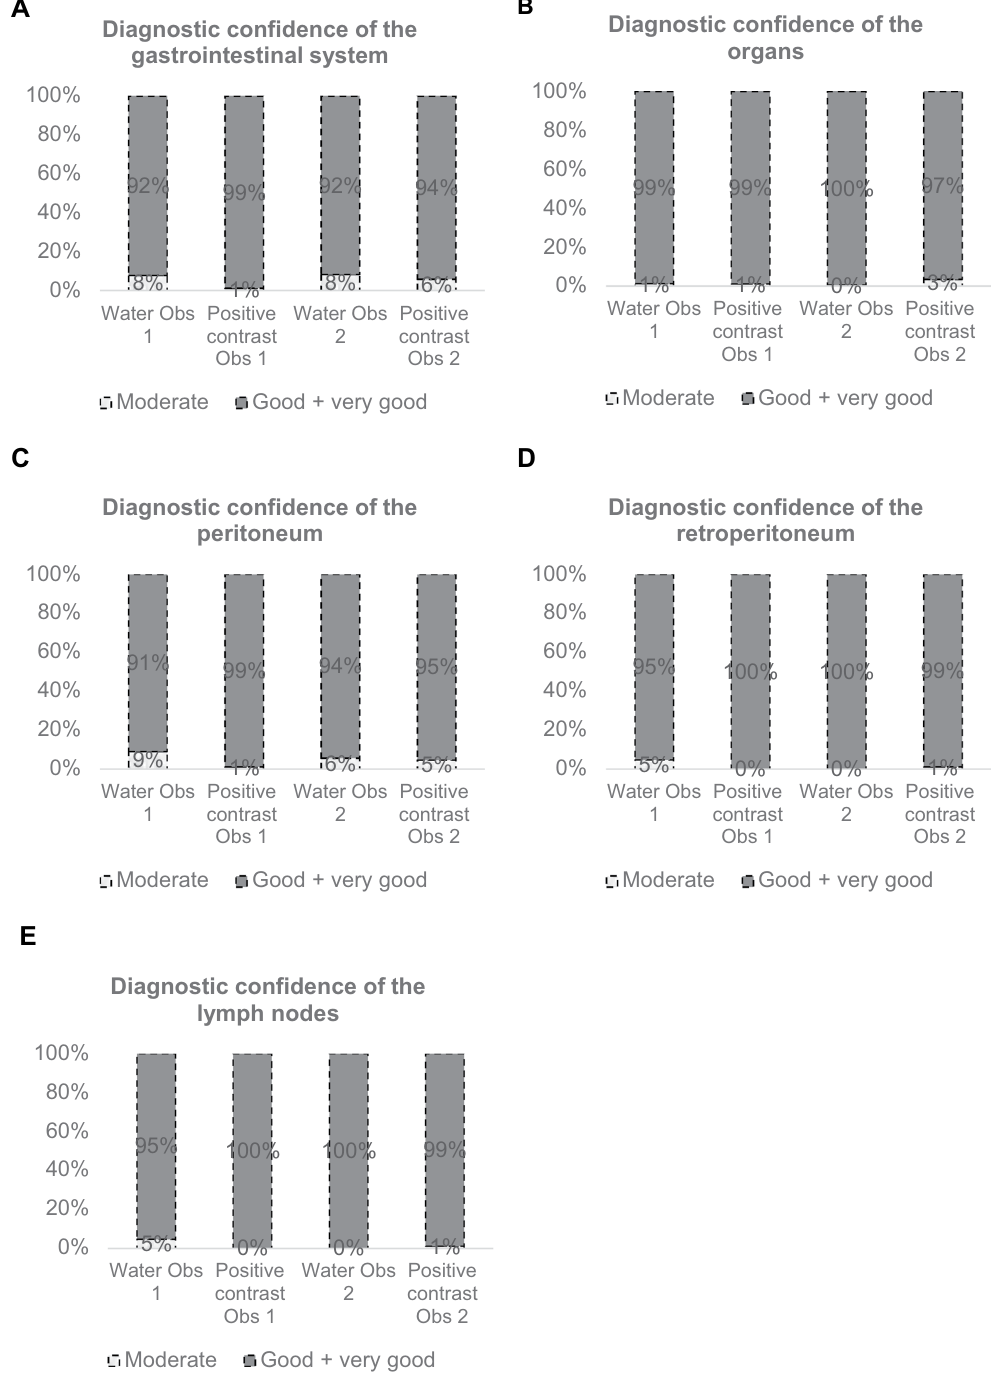
Figure 4. The diagnostic confidence of the different regions by observer 1 and observer